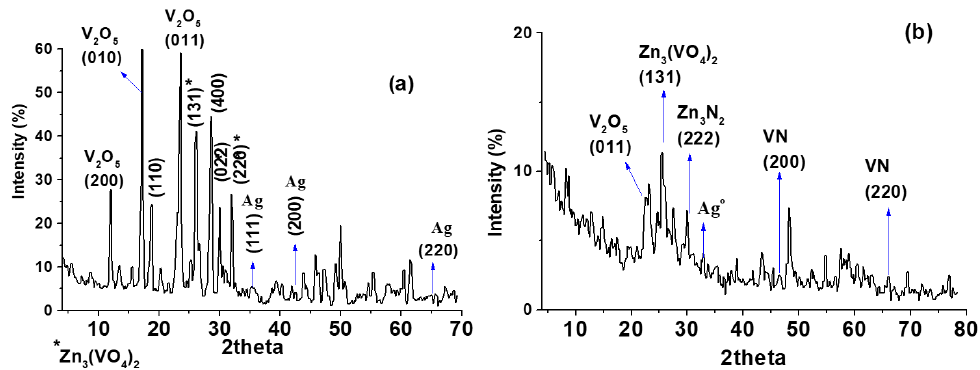
Figure 1. IR spectra of ( a ) [Ag 0.05 ZnO 0.05 V 2 O 5(0.90) ]; and ( b ) [Ag 0.05 ZnO 0.05 V 2 O 5(0.90) ] N . The XRD patterns of [Ag 0.05 ZnO 0 . 05 V 2 O 5(0.90) ] and [Ag 0.05 ZnO 0.05 V 2 O 5(0.90) ] N have been interpreted using JCPDS No. 89-2483, ICDD PDF No. 35-768, and ICSD No. 98-018-0878, Figure 2. The XRD profile of [Ag 0.05 ZnO 0.05 V 2 O 5(0.90) ] illustrates nanocrystals of V 2 O 5 and particles exhibit a low degree of crystallinity. A small peak is observed at 2 θ = 38.2°, which